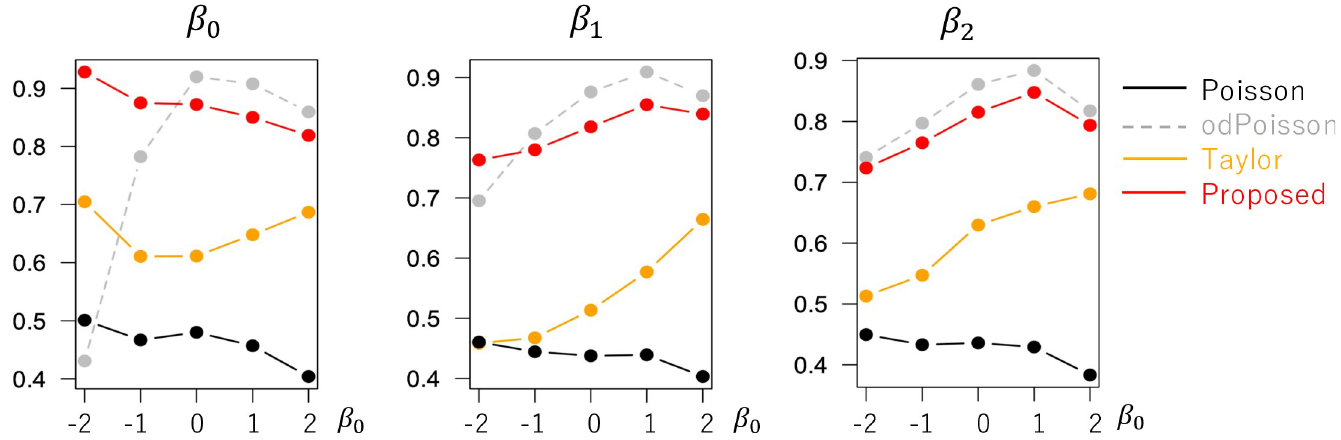
Fig 10. Means of (estimated standard error)/(standard deviation of the estimated coefficient values) ( N = 200; x − axis: β 0 , y-axis: RMSE).